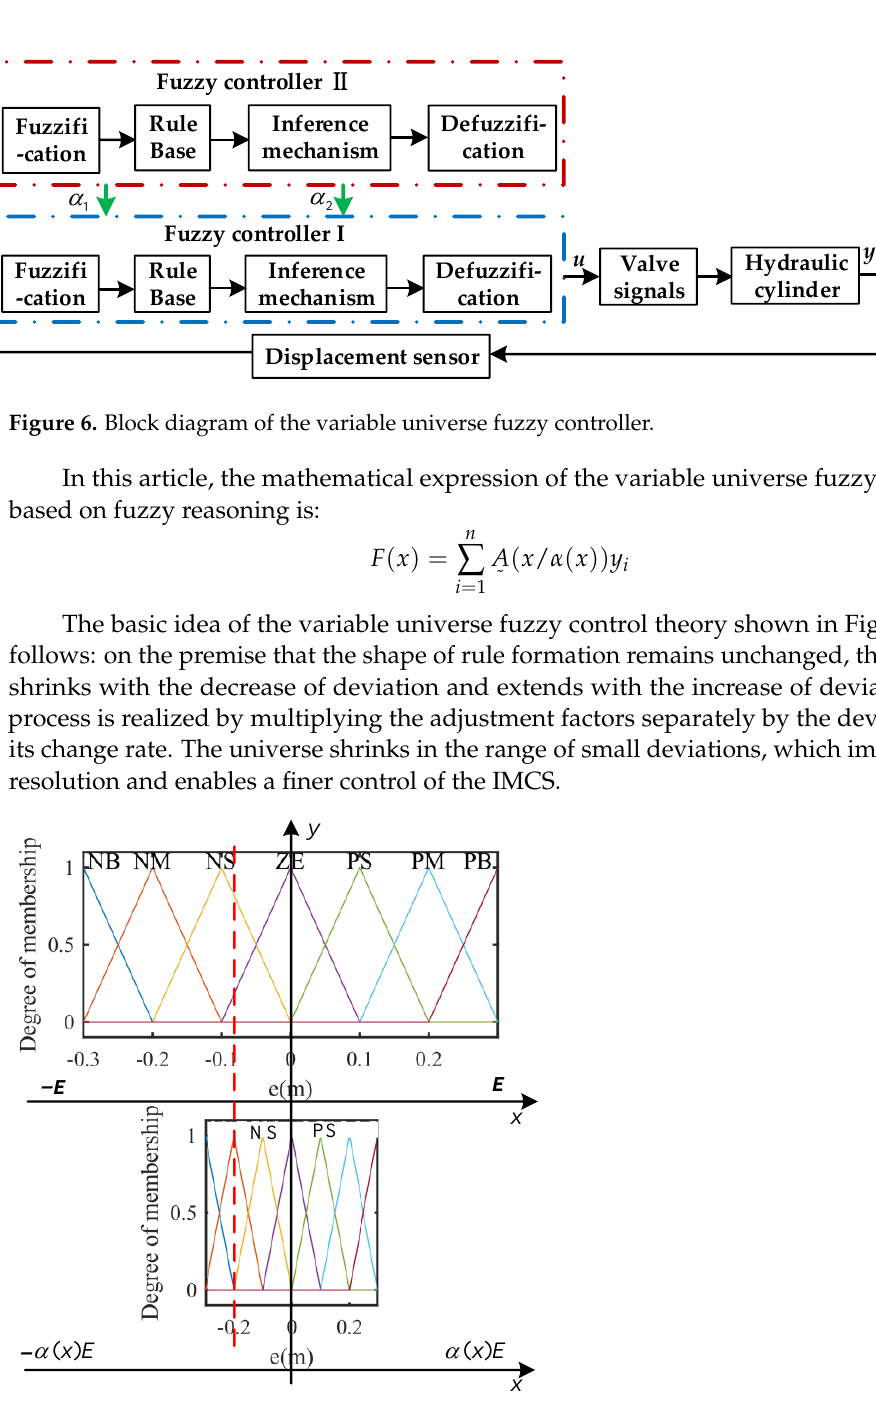
Figure 7. Basic idea of the variable universe fuzzy control. The fuzzy subset of displacement deviation after shrinking is: